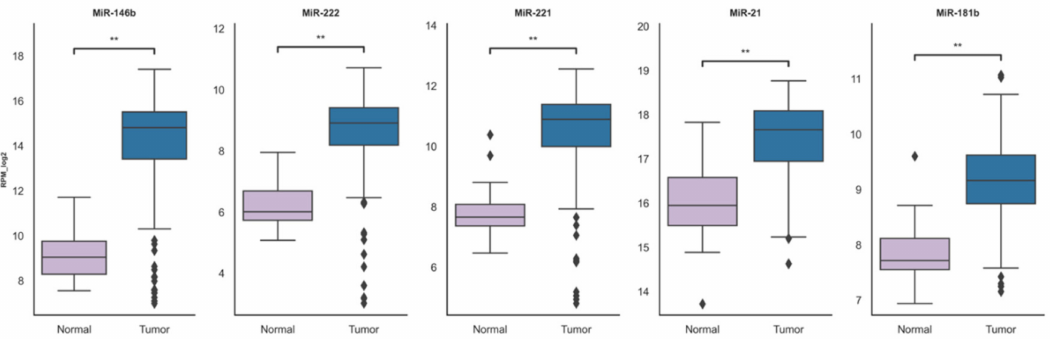
Figure 2. The filtered data comparison of miRNA expression between normal and cancerous tissue groups. The box squares represent the data within 25 and 75 percentiles, line in the middle shows the median, the outliers are shown as diamonds. ** p < 0.0001. A total of 207 cases analyzed (normal n = 31, tumor n =